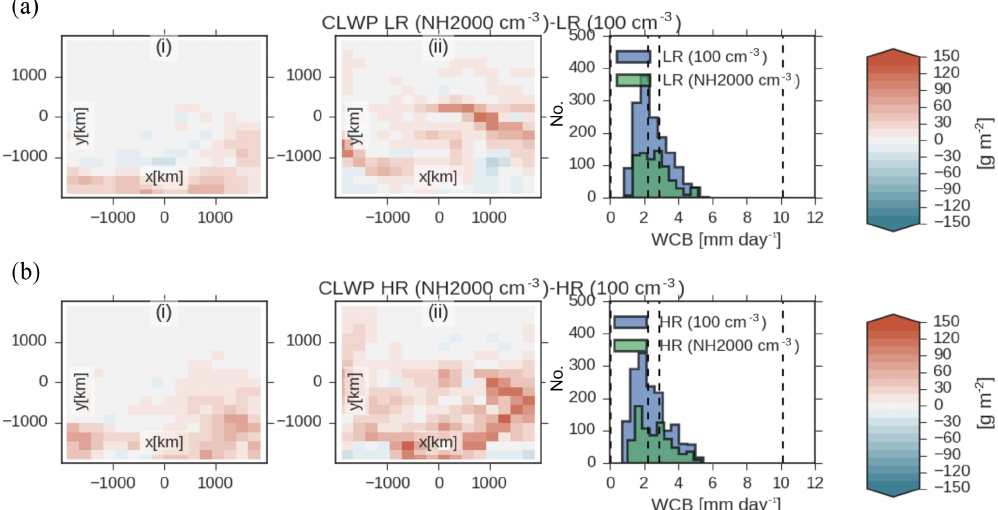
Figure 8. The difference in mean cyclone composites of CLWP between the high and low N acc simulations for (a) the GCM-surrogate low-resolution (LR) simulation and (b) the convection-permitting (HR) simulation. Differences in mean cyclone composites for different WCB regimes are shown. It should be noted that the relatively short integration time (relative to the observations) of the simulations did not yield a large number of cyclones in the top tercile of observations and only the first two WCB regimes are shown in contrast to Fig. 7. The distribution of cyclones by WCB in the simulations is shown on the rightmost